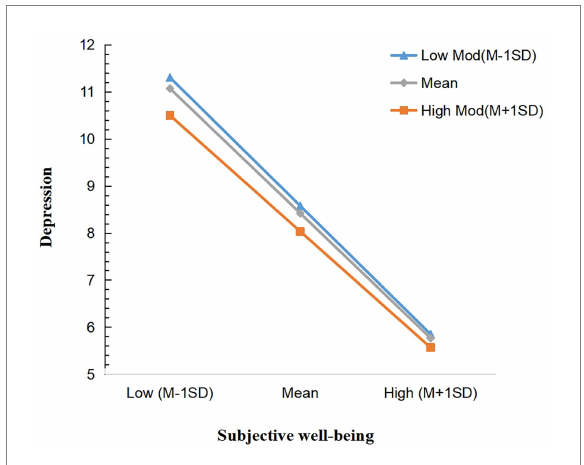
FIGURE 3 Simple slope analysis. The blue line represents a low level of degree of digitization and the orange line represents a high level of degree of